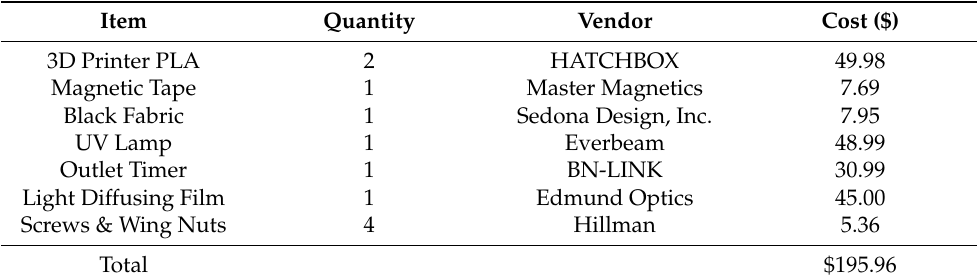
Table 1. DUV Light System